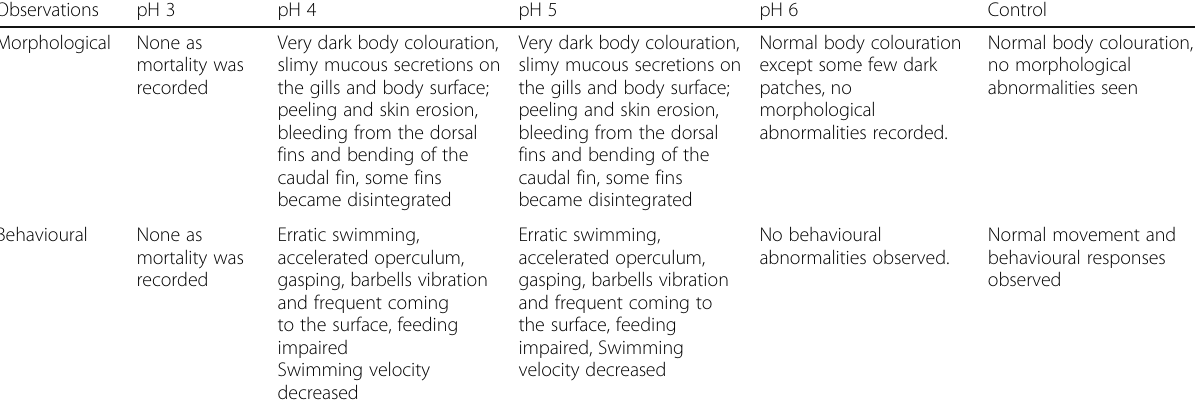
Table 5 Morphological and behavioural observations of juvenile of O. niloticus in low pH and control